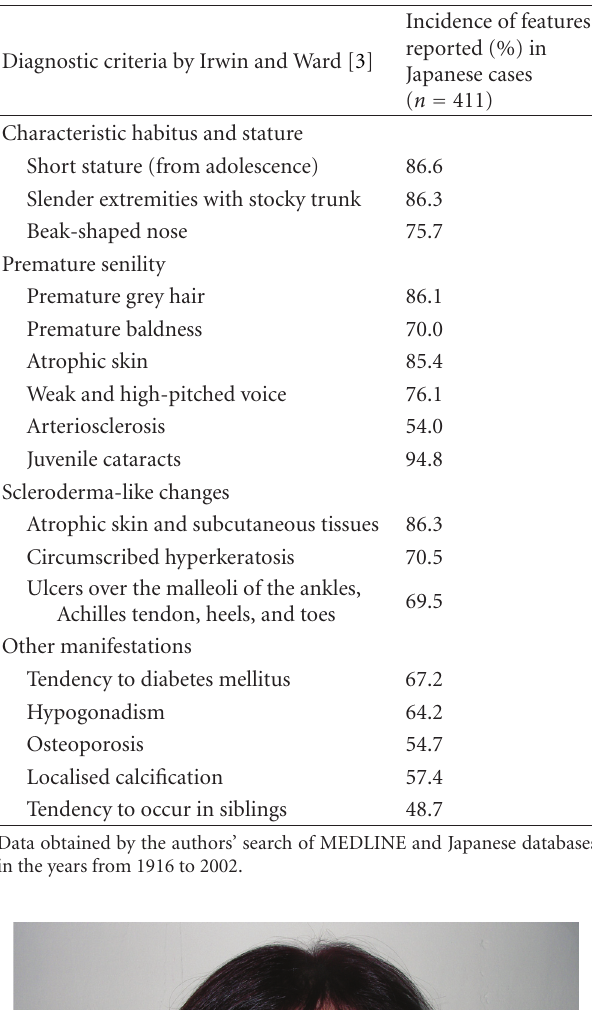
Table 1: Characteristic features of Werner’s syndrome.